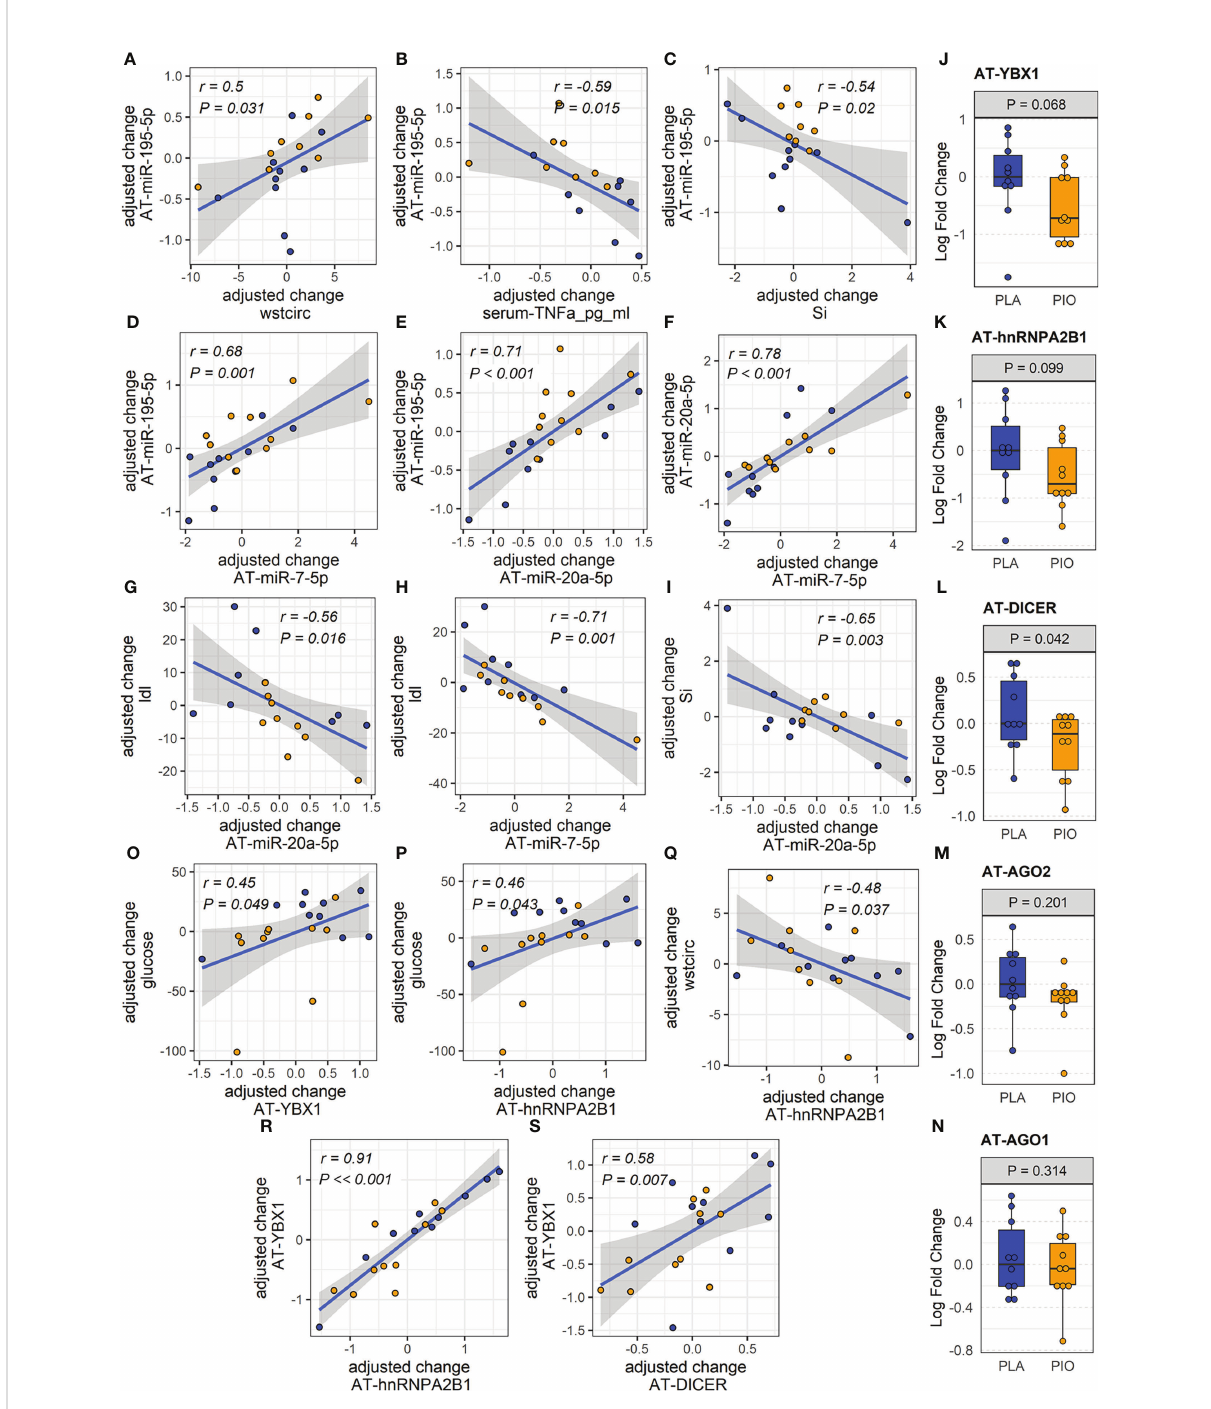
FIGURE 2 miRNAs and exosome sorting genes in AT. (A-I) Signi fi cantly correlated changes between DE AT-miRNAs and between DE AT-miRNAs and relevant clinical and biochemical measures. (J-N) Expression of AT transcripts involved in miRNA exosomal sorting and miRNA biogenesis. (O-S) Signi fi cantly correlated changes between AT genes involved in miRNA exosomal sorting and relevant clinical measures. Yellow color fi lling for pioglitazone group, blue color fi lling for placebo